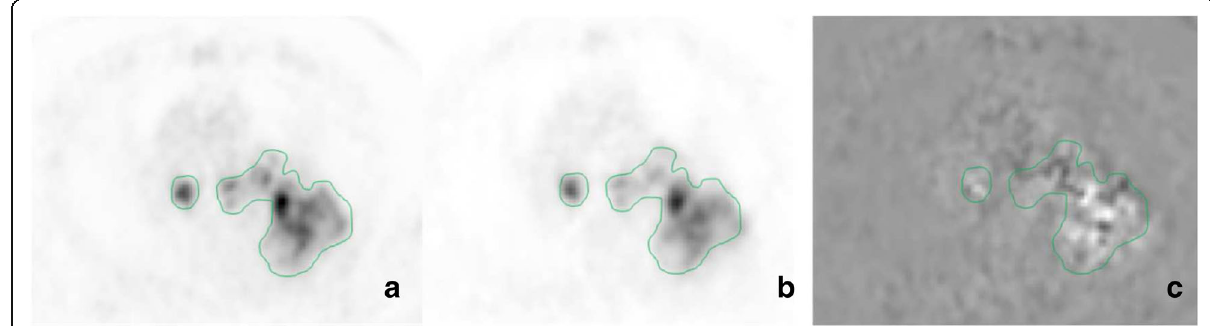
Fig. 6 Example of SUV ( a ), K i ( b ), and subtraction ( c = a – b ) PET images generated by our approach for a patient with multiple lesions. The subtraction image ( a – b ) is obtained after the normalisation of the images considering the total number of counts measured in the slice. The external contours of the lesions are represented by the solid green